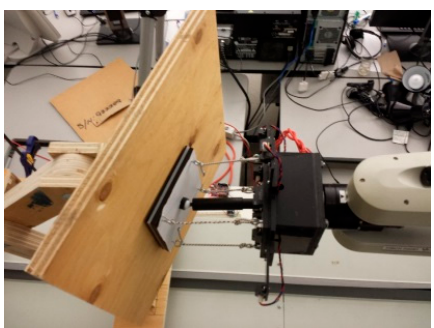
Figure 22. Compliant wrist operating in contact mode while physically interacting with an angled planar surface.